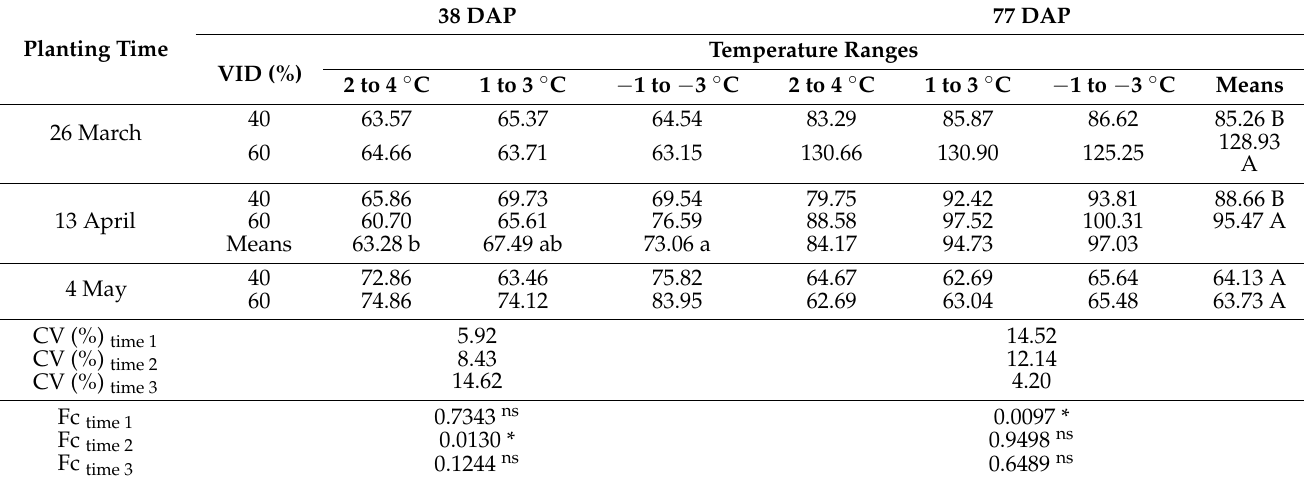
Table 2. Relative index of chlorophyll (RIC) in garlic plants of the Ito variety at 38 and 77 days after planting (DAP), under different temperatures ranges and visual index of overcoming dormancy (VID).